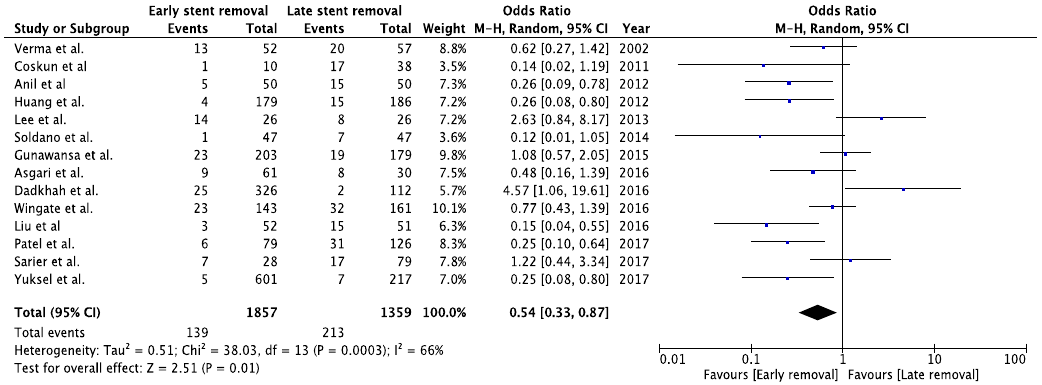
Figure 2. Quality assessment of the included studies.